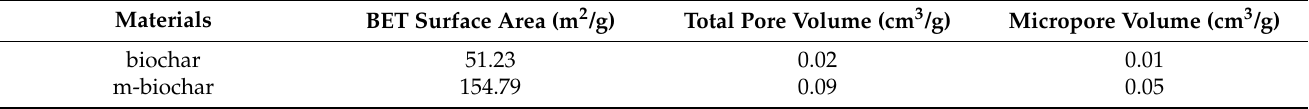
Table 1. Physical characteristics of the pristine biochar and